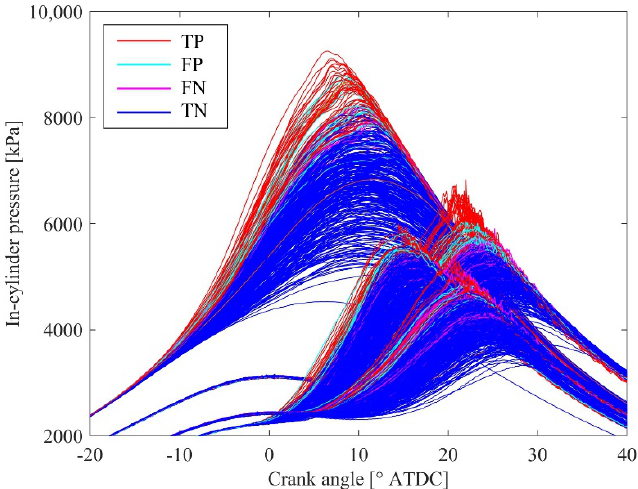
Figure 10. In-cylinder pressure color-coded by predicted class and actual class based on the results of the prediction using multiple operating conditions.